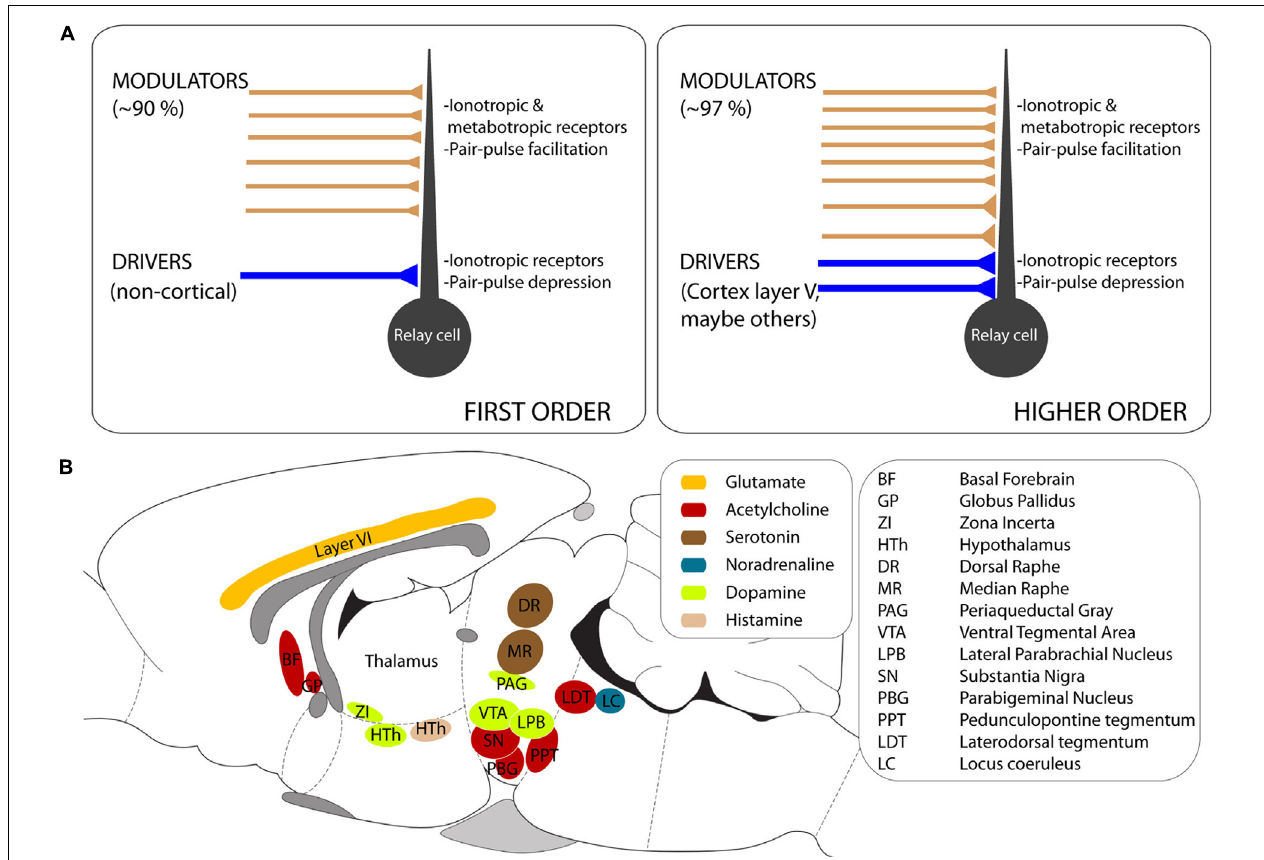
which it has been tested, the postsynaptic responses facilitate under repetitive stimulation. (B) Approximate location of the brain regions that provide modulator afferents to the thalamus, color-coded for the neurotransmitter they use.The outline of a rodent brain is used for convenience, although the diagram combines results from different species (see text for